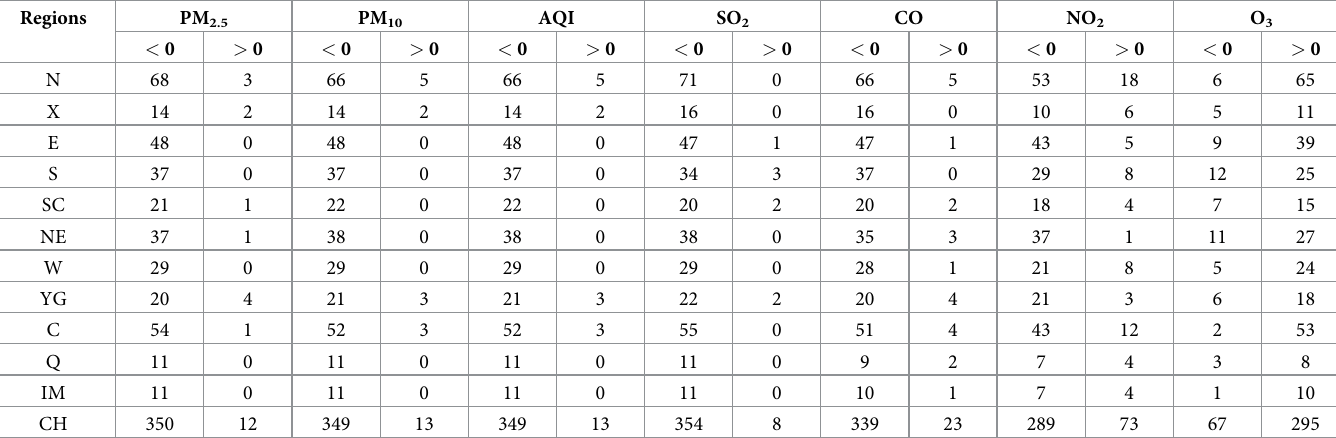
Table 4. Quantity of cities showing ‘ < 0’ and ‘ > 0’ of relative change between 2015 and 2019, regions are indicated by the first capital letter.